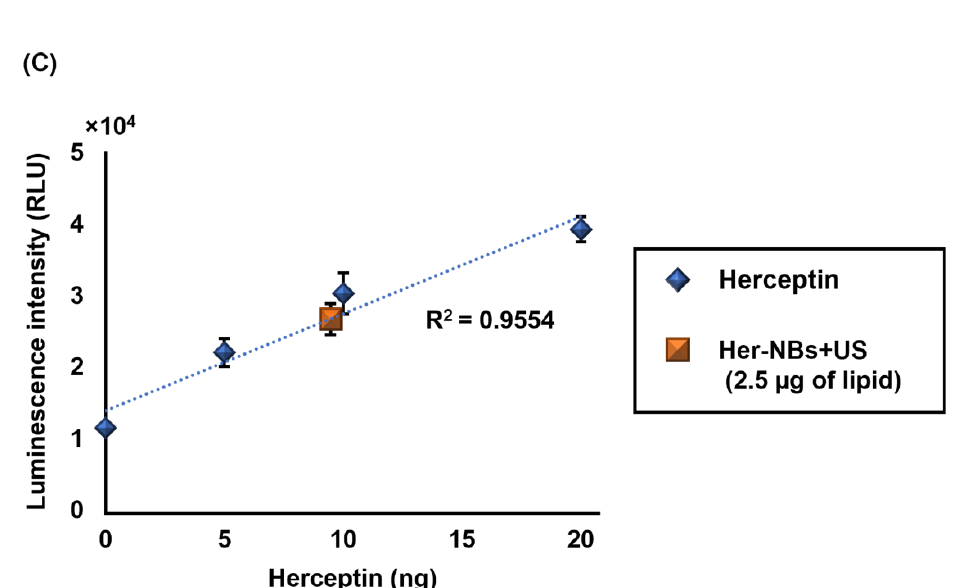
Figure 3. Activity of Herceptin on Her-NBs before/after TUS exposure. To evaluate the activity of Herceptin, luminescence intensity of Jurkat effector cells, expressing NFAT-RE-luc2, was measured by ADCC reporter bioassay against SKOV3 (T). SKOV3 cells were plated in a 96-well plate the before assay. On the day of assay, samples and effector cells (E) were added to the plate (cell rate; E: T = 15: 1). After 6 h of incubation at 37 °C/5% CO 2 condition, Bio-Glo TM luciferase assay regent was added, and the luminescence intensity was determined using luminometer. ( A ) Luminescence intensity of Herceptin in Her-NBs after TUS in serial concentration of lipid. ( B ) Comparison of luminescence intensity of Her-NBs before and after TUS exposure in 2.5 µg of lipid. ( C ) Calculation of titer of Herceptin in Her-NBs using the standard curve of the amount of Herceptin versus luminescence intensity. Data = mean ± SD ( n = 4). The unpaired t -test was used for statistical analysis.